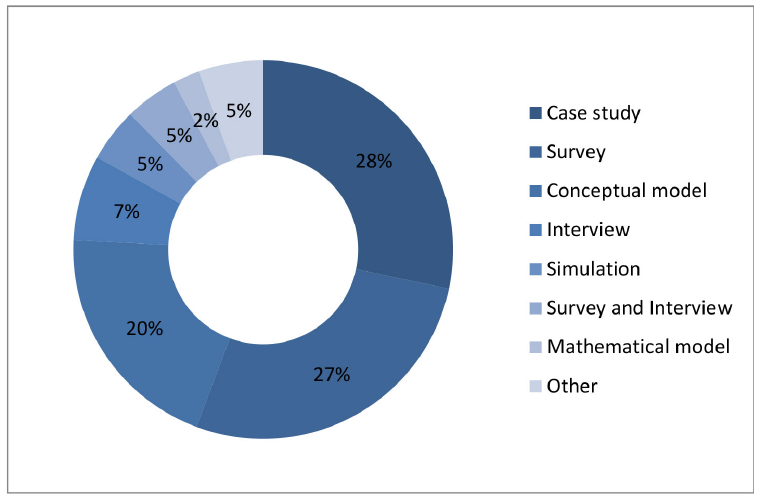
Figure 2. Breakdown of reviewed papers by research